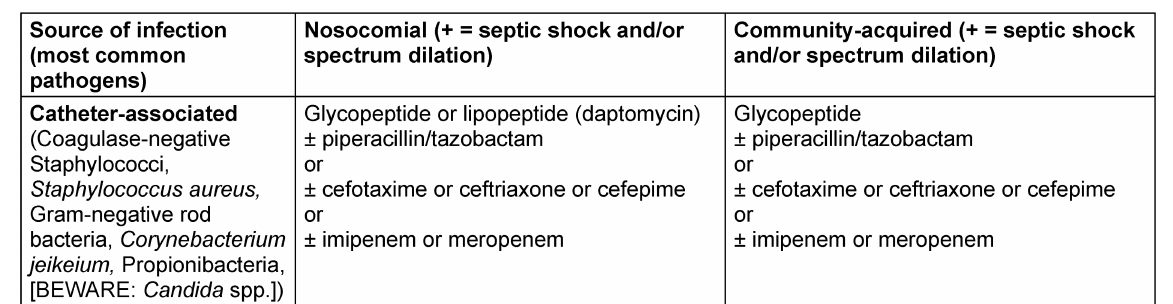
Table 1: Recommendations for the treatment of sepsis with unknown pathogen.